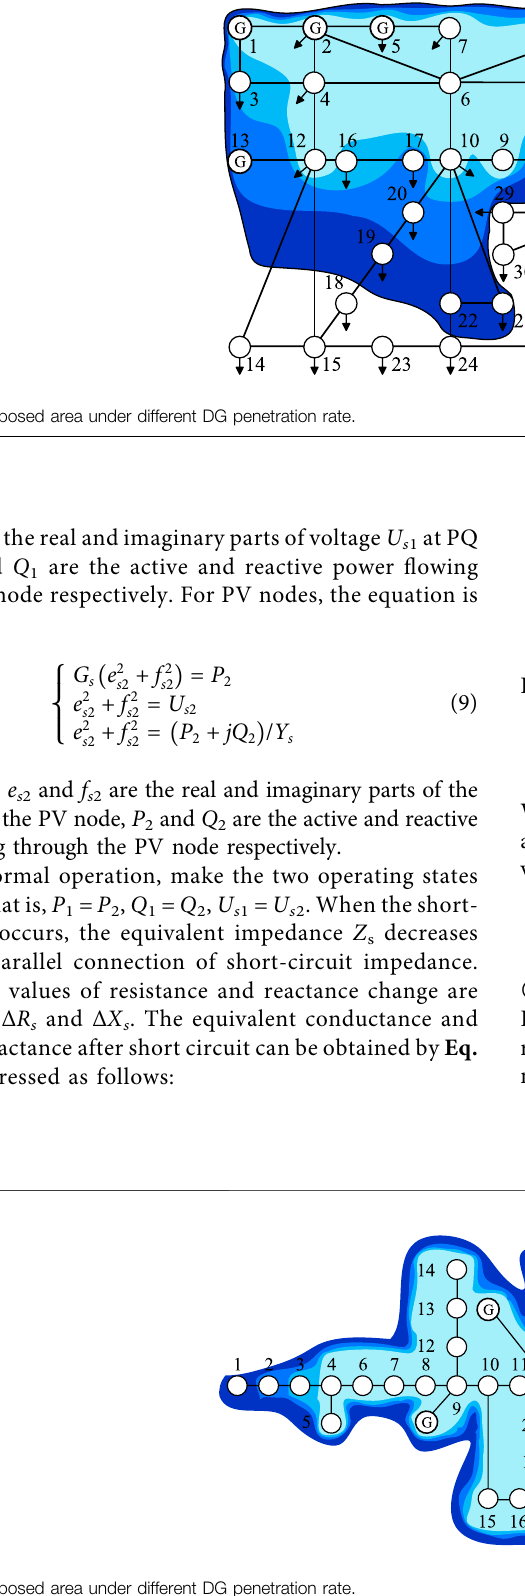
FIGURE 6 | Exposed area under different DG penetration